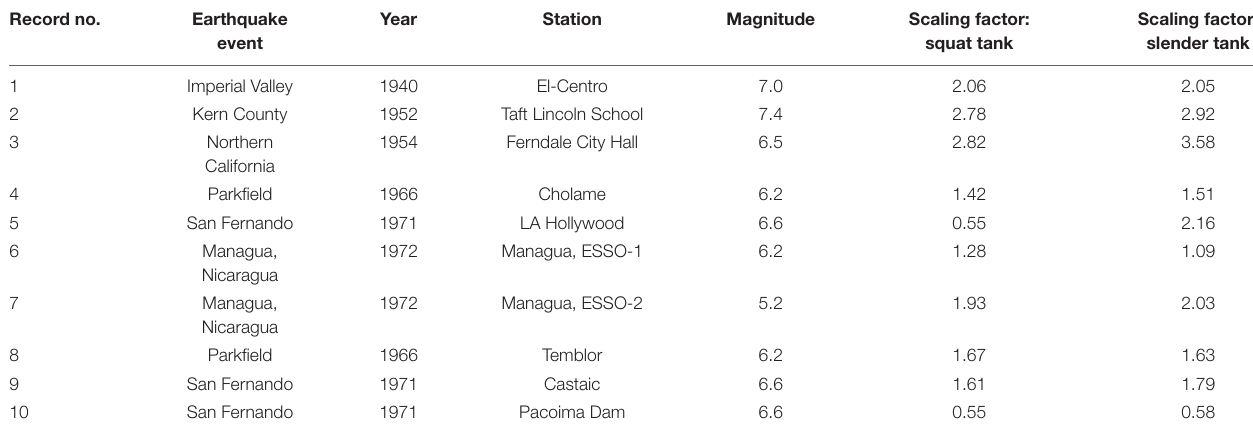
TABLE 1 | Seismic records from PEER-NGA database. Record